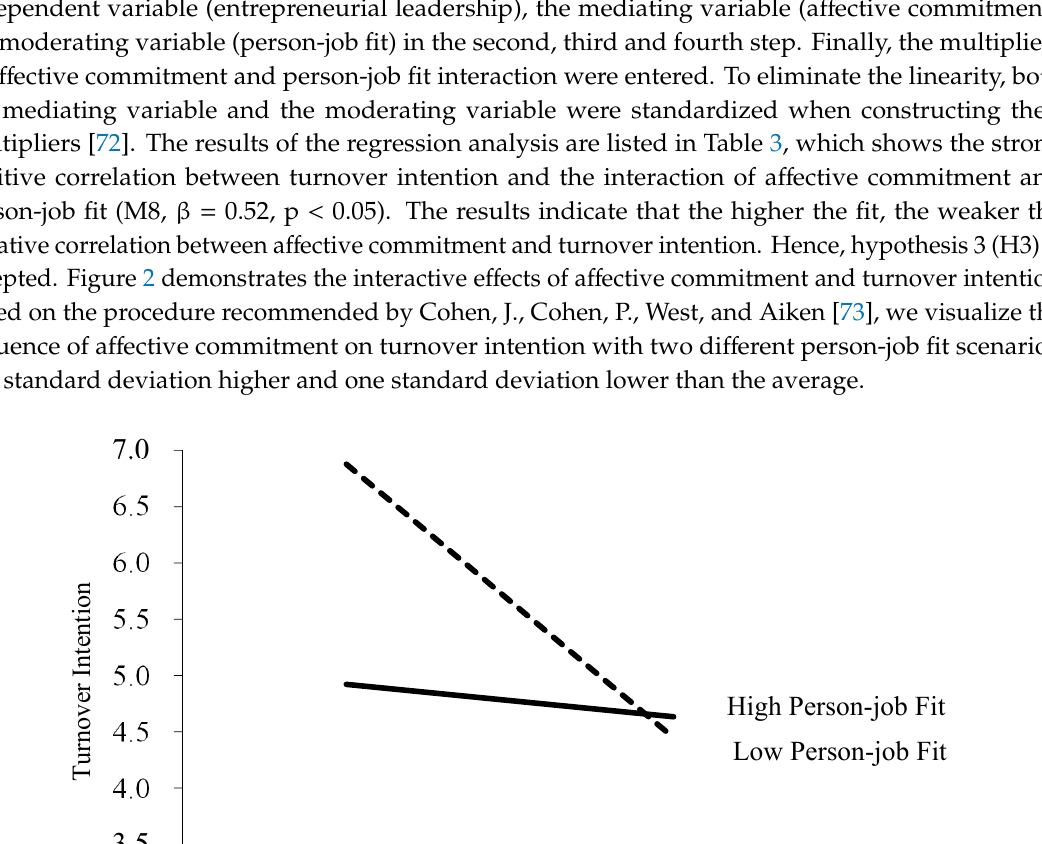
Table 4. Mediation model: mediating role of affective commitment between entrepreneurial leadership and turnover intention.